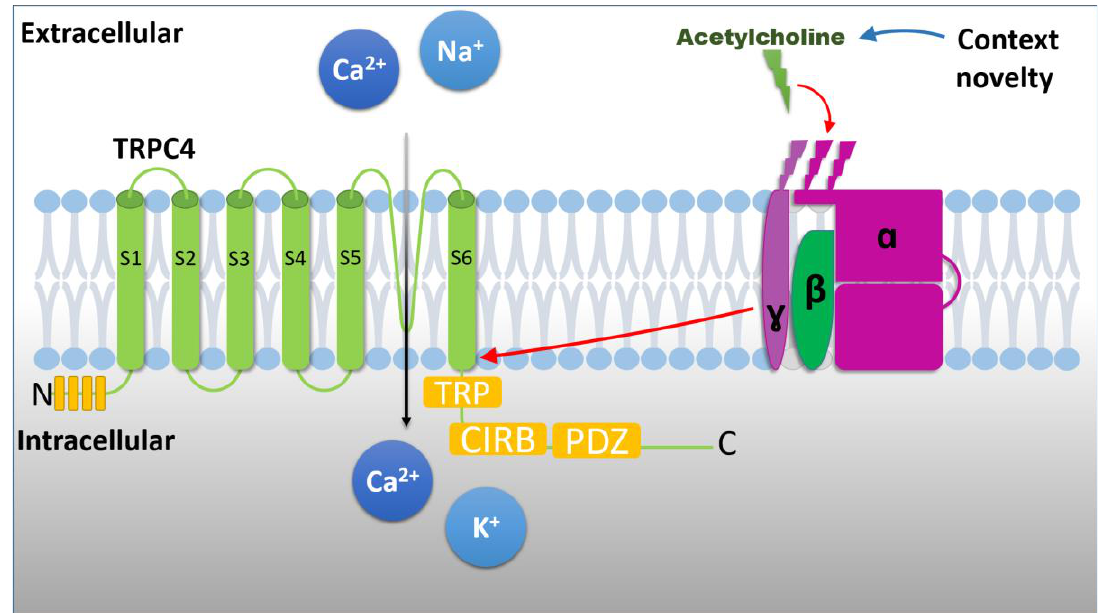
Figure 5. A TRPC4 channel with N terminus and C terminal has TRP, CRIB, and PDZ domains. Signal transduction through muscarinic receptors is triggered by acetylcholine neurotransmitter. Following acetylcholine binding to the receptor, TRPC4 channel is activated through G protein cascade. The acronyms are CIRB: calmodulin- and inositol triphosphate receptor (InsP3R)-binding site; PDZ: amino acid binding motif; TRP: TRP-like domain.